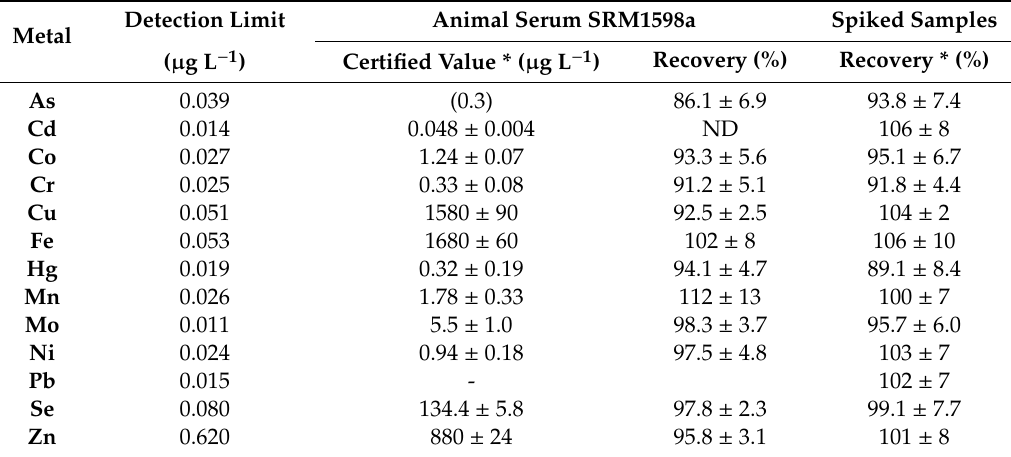
Table 1. Results of the analytical quality program applied for the ICP-MS determination of the essential trace and toxic elements in serum of dogs in the present